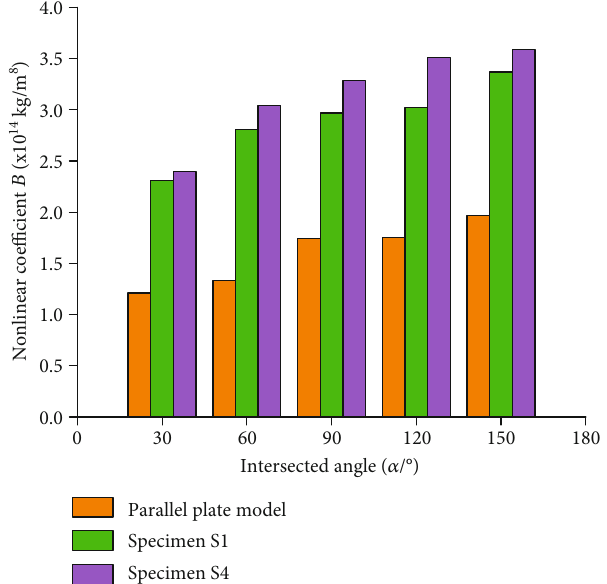
Figure 24: The comparison of nonlinear coe ffi cients for rough fractures with di ff erent interested